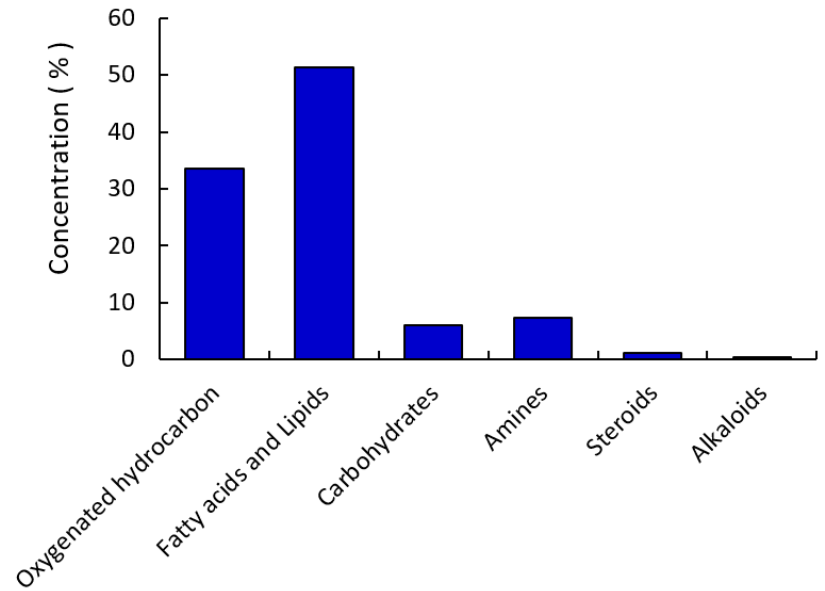
Figure 2. The categorized chemical constituents identified from the extracted R. vesicarius according to GC–MS analysis.